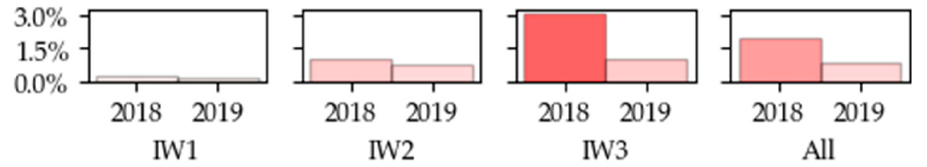
Figure 10. Tropical site percentage of forest pixels misclassified as low vegetation disaggregated by sub-swaths.